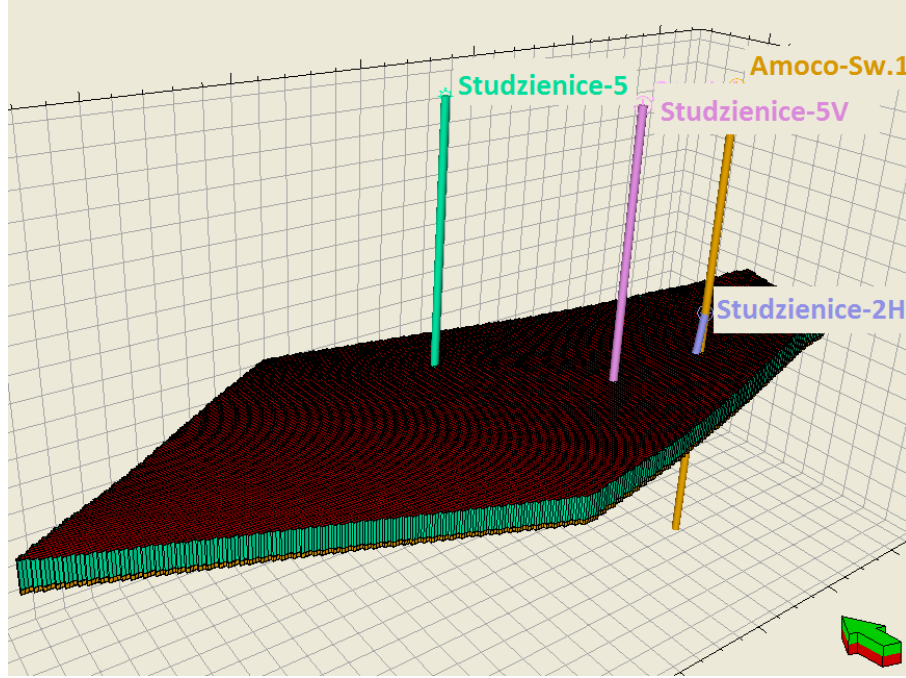
Figure 4. Simulation model of CBM extraction from seams 333, 336, and 337. Table 3. Structural parameters of the simulation model for CBM extraction.